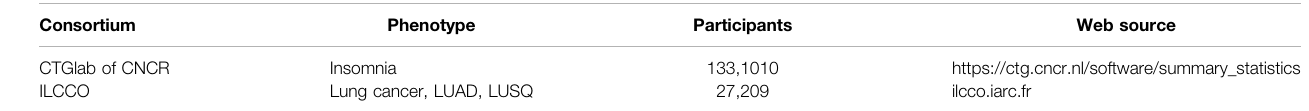
TABLE 2 | Power and F statistic for Conventional Mendelian Randomization Analysis (two-sided α (cid:1) 0.05). Outcome Sample size of GWAS on outcome